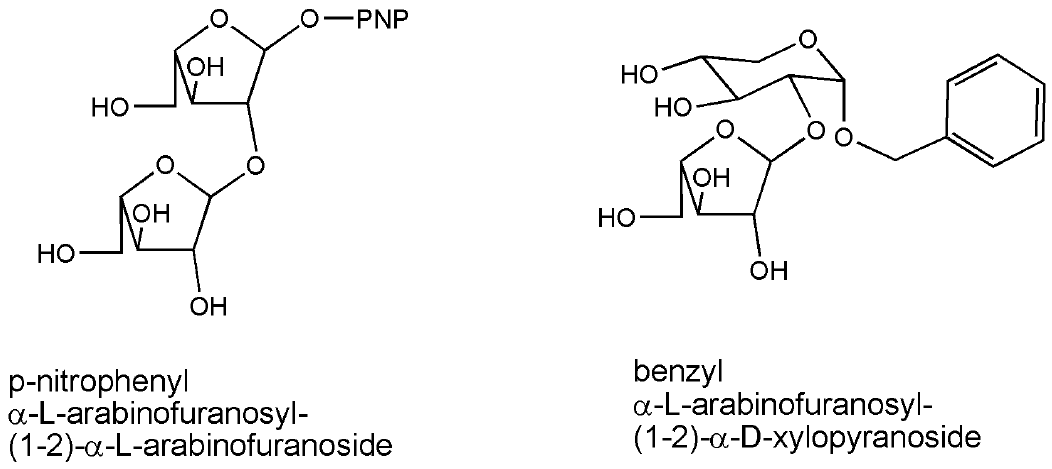
Figure 1. Arabinofuranosides synthesized by thermophilic α- L -arabinofuranosidase from Thermobacillus xylanilyticus